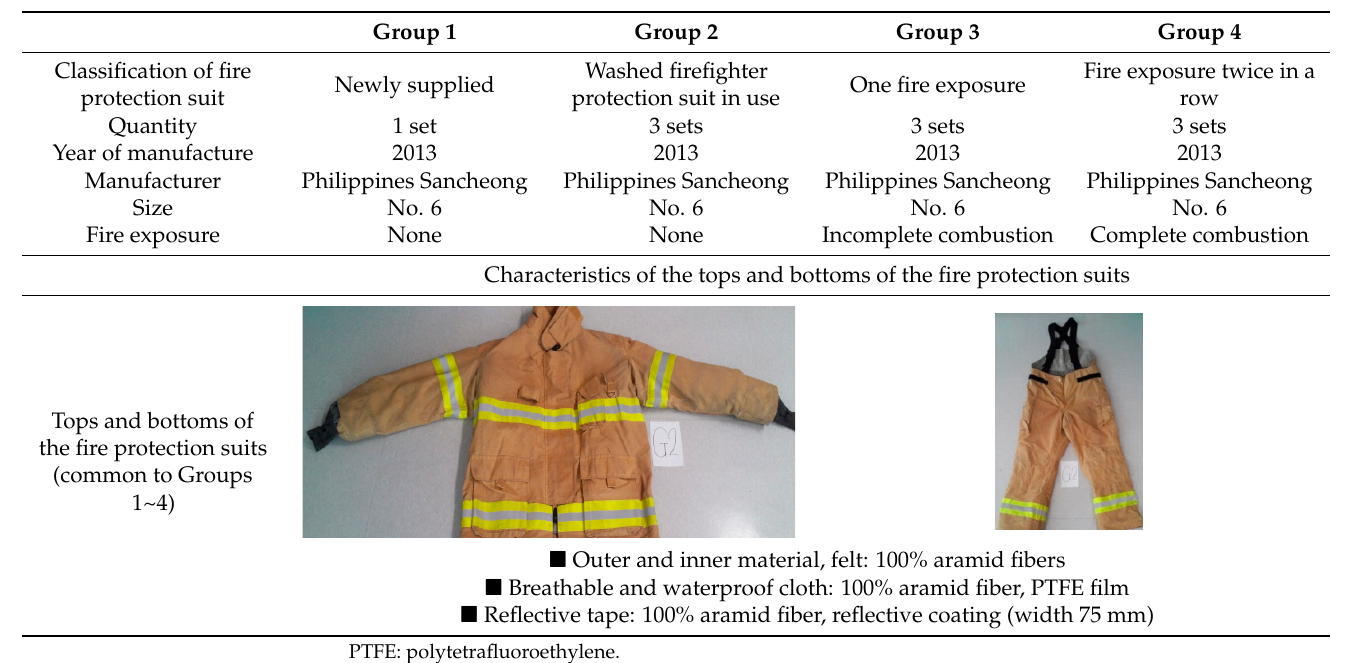
Table 1. Demographic characteristics of simulated fire protection suits by group distribution.